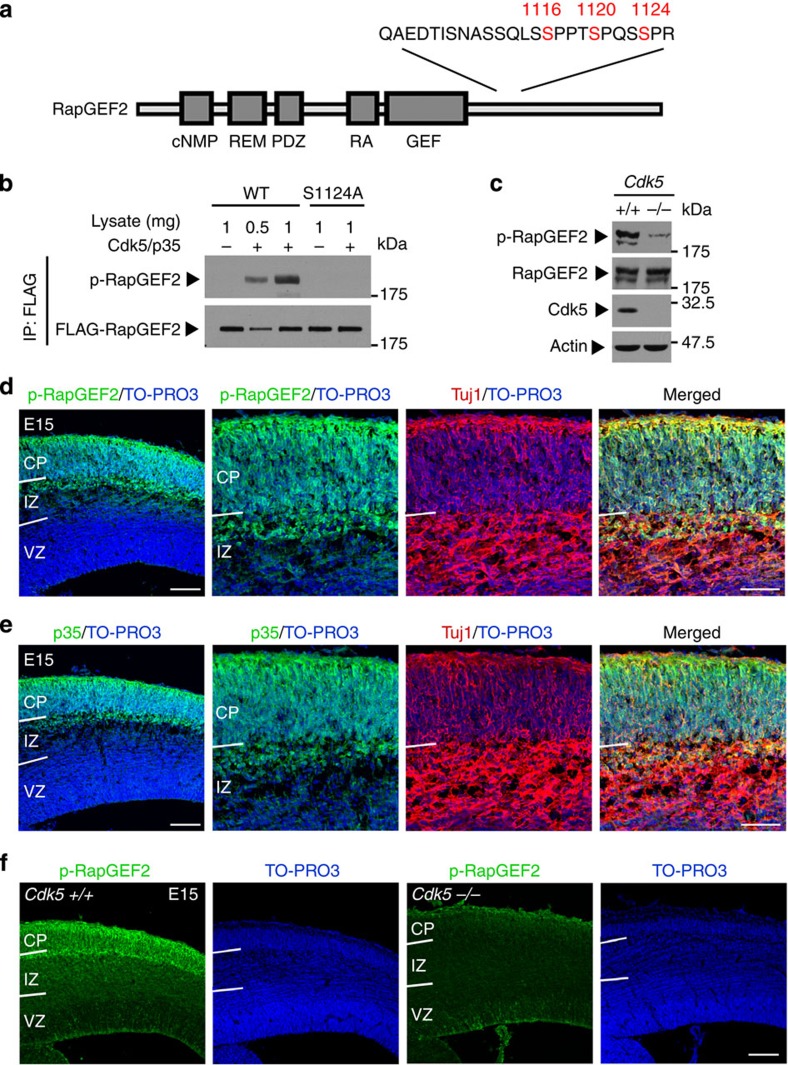
RapGEF2 is an in vivo substrate of Cdk5/p35.(a) Diagram of the domain structure of RapGEF2 protein. The phosphopeptide identified by the phosphoproteomic analysis is shown. The three proline-directed serine sites are highlighted. (b) Validation of p-RapGEF2 antibody in HEK293T cells. (c) Absence of RapGEF2 phosphorylation at Ser1124 from Cdk5-deficient cortices at E18. Actin served as the loading control. The experiment was repeated for at least three times. See full-length blots in Supplementary Fig. 10. (d) Spatial expression of p-RapGEF2 in the developing mouse cortex. Representative E15 cortical sections were co-stained for p-RapGEF2, Tuj1 and TO-PRO3. The experiment was repeated for at least three times. (e) Spatial expression of p35 in the developing mouse cortex. Representative E15 cortical sections were co-stained for p35, Tuj1 and TO-PRO3. The experiment was repeated for at least three times. (f) Wild-type or Cdk5-deficient cortical sections at E15 were stained for p-RapGEF2 and TO-PRO3. Scale bar, 100 μm (d–f).